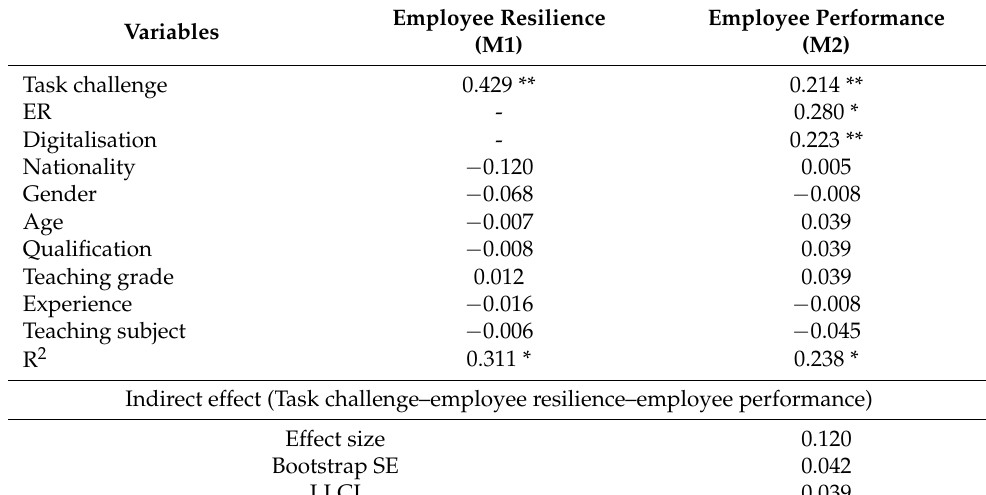
Table 5. Mediation analysis (Process Macro Model 4).